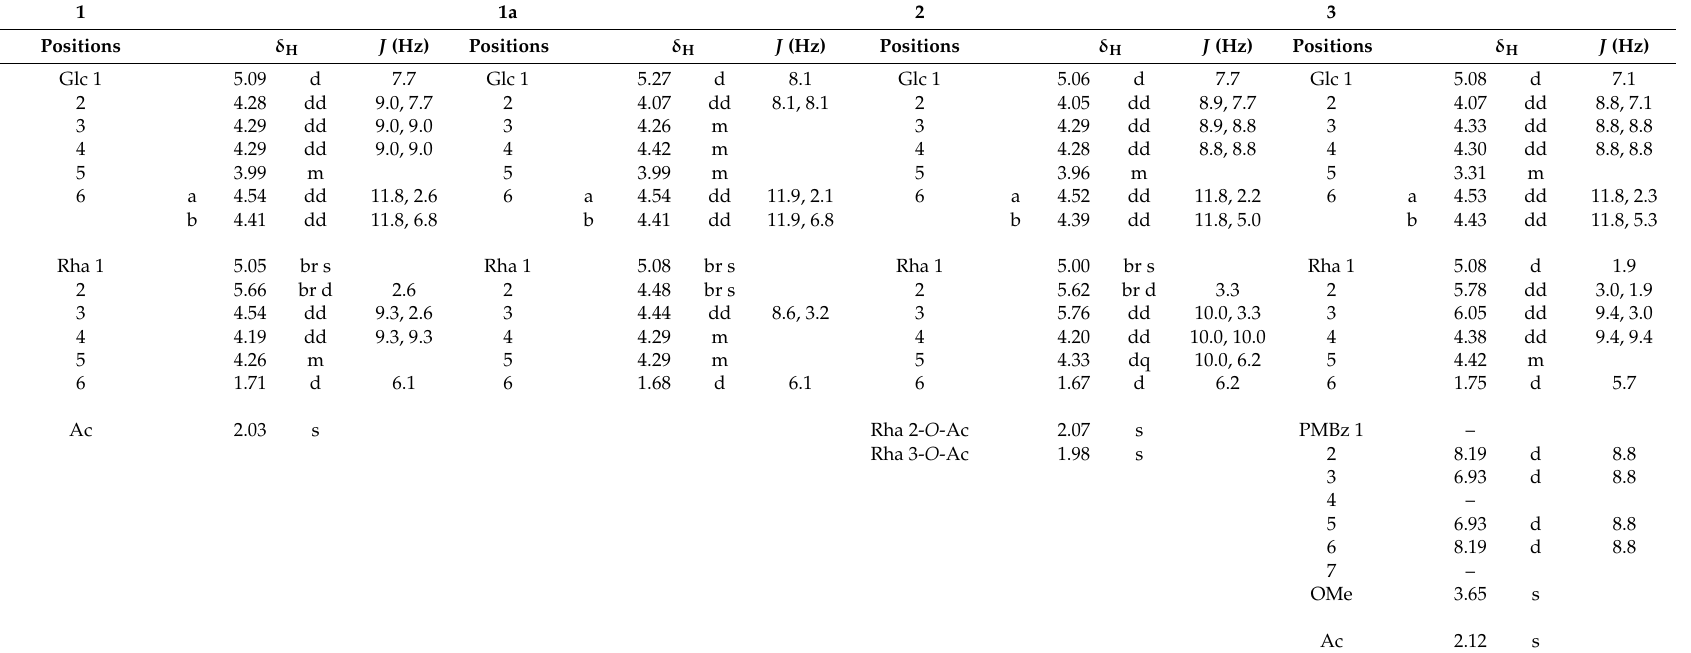
Table 1. 1 H-NMR spectral data for the sugar and acyl Moieties of 1 – 6 and 1a in C 5 D 5 N.